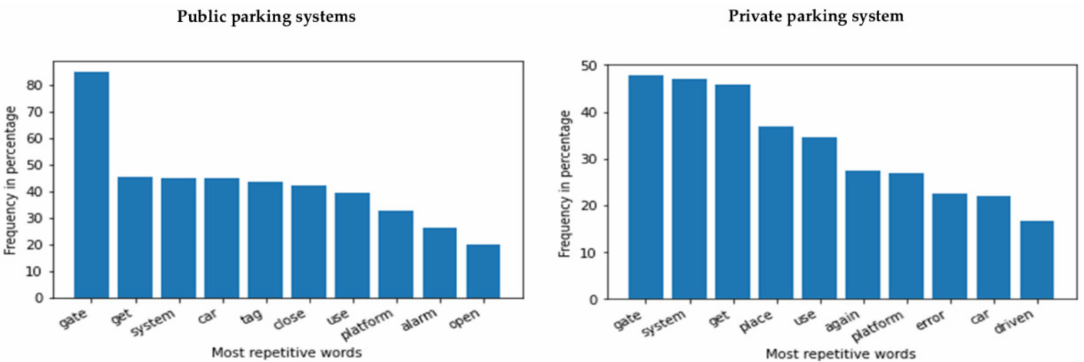
Figure 10. The most repetitive words in percentage in the entire description field entry (reason column) in failure data for public ( left ) and private ( right ) parking systems.